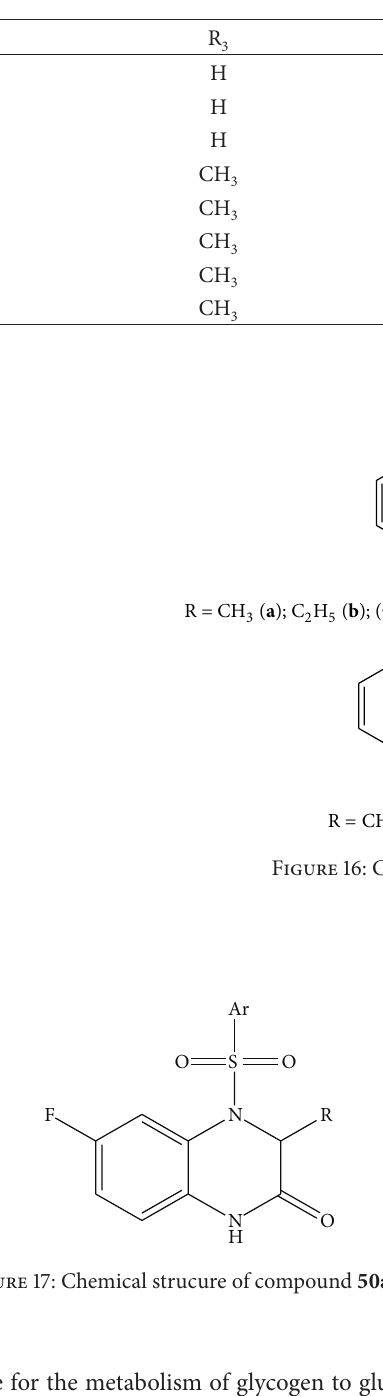
Table 7: Antiviral activity of compounds 50a – h .